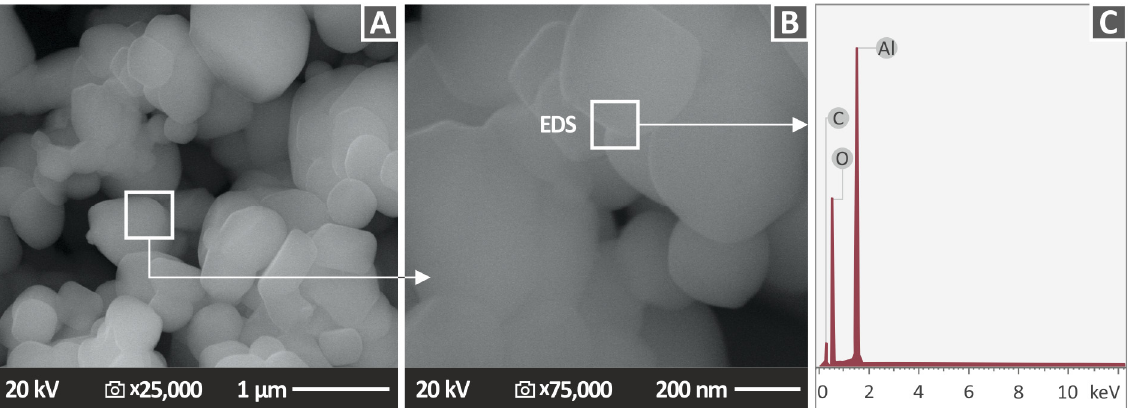
Figure 9. SEM images of Al 2 O 3 powder at two magnifications: ( A ) 25,000×, ( B ) 75,000×, and ( C ) the corresponding EDS spectrum acquired from the Al 2 O 3 powder.